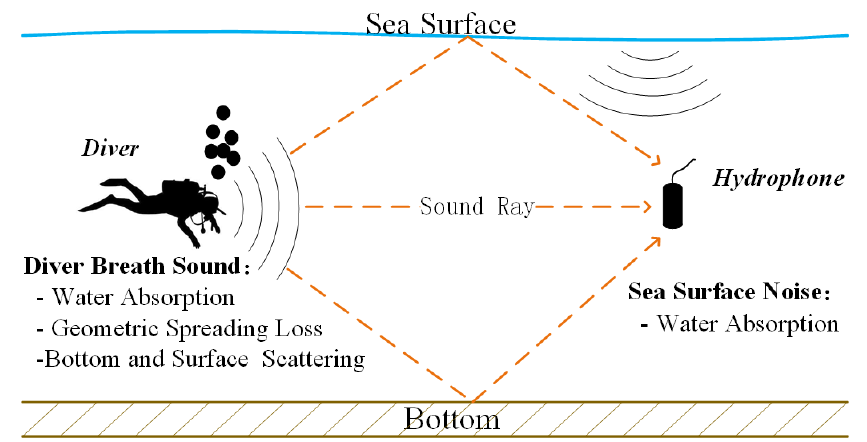
Figure 1. Underwater acoustic channel model for diver detection. Transmission loss contains geometry diffusion loss, water absorption and scattering by bottom and surface. Observed signals are affected by ambient noise, for example, wind noise from sea